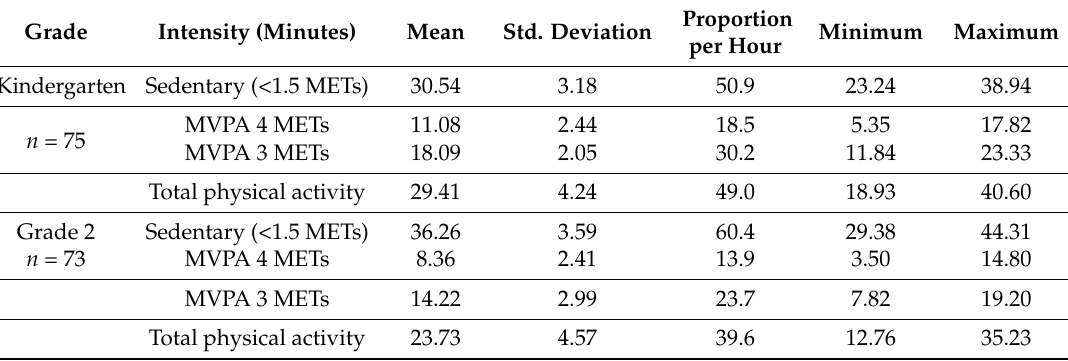
Table 2. Physical activity in minutes per hour for the cross-sectional sample in kindergarten and grade 2.